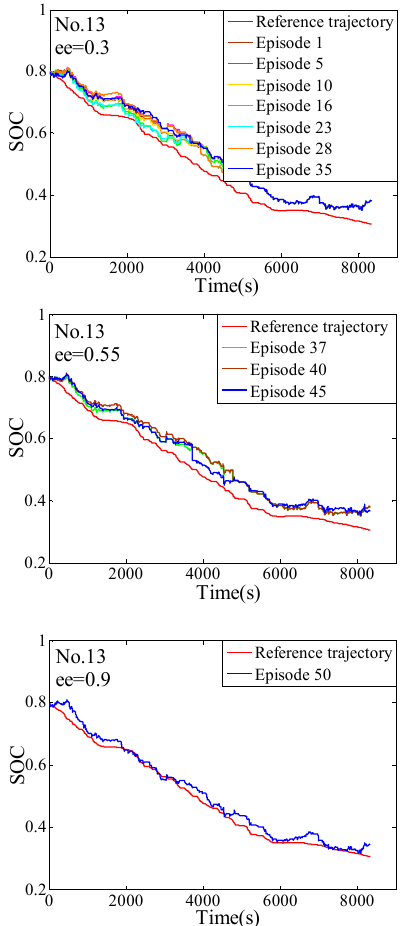
Figure 12. The training process of combined driving cycle 13.